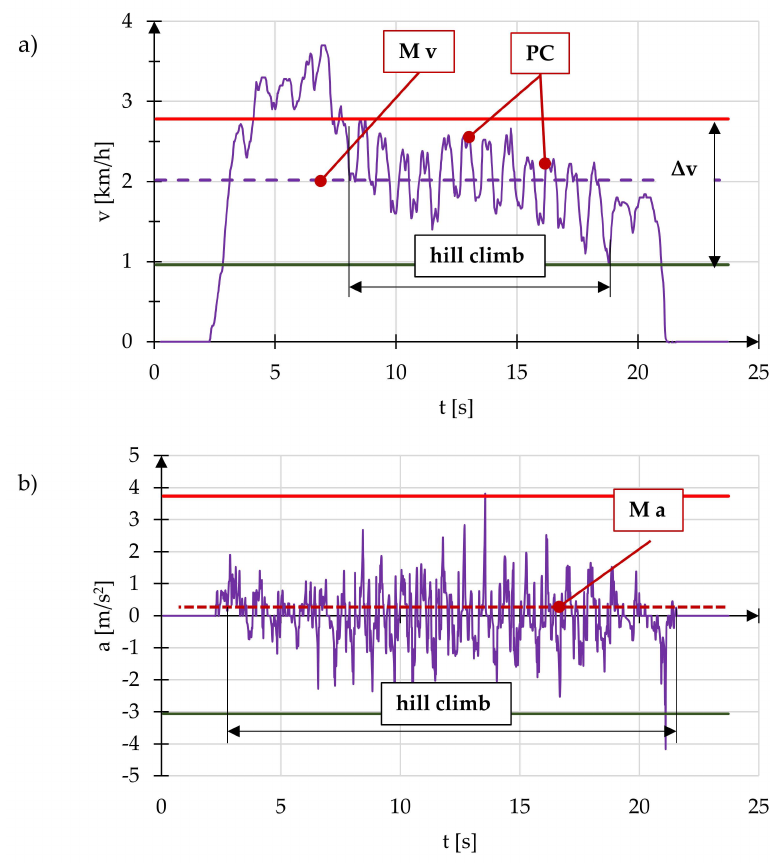
Figure 4. Examples of the graphs analyzed in the tests: speed ( a ) and acceleration ( b ); PC: the end points of the propulsive cycle, M v : the average speed of the wheelchair on the hill, M a : the average acceleration of the